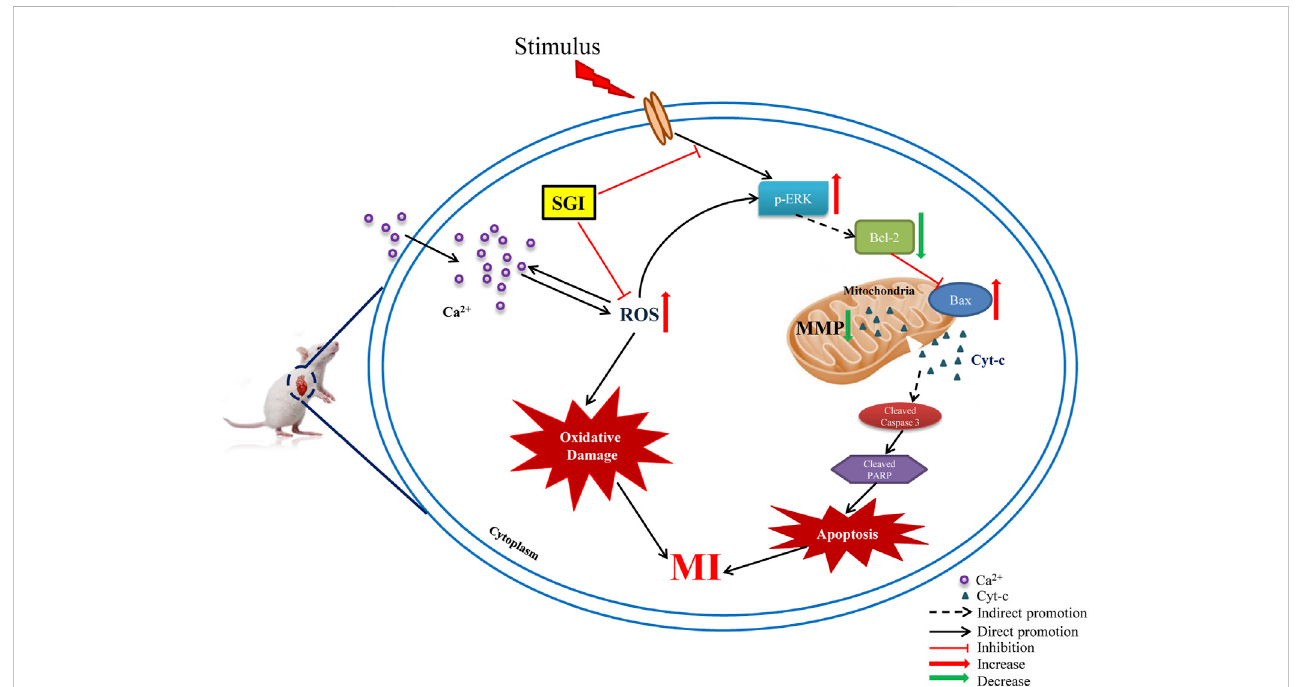
FIGURE 10 Schematic diagram of the underlying molecular mechanism of SGI against MI. ROS (reactive oxygen species); MI (myocardial ischemia); MMP (mitochondrial membrane potential); p-ERK1/2 (phosphorylation extracellular signal-related kinases1/2); Cyt-c (cytochrome c); PARP (poly-ADP ribose polymerase); Caspase-3 (cysteinyl aspartate speci fi c proteinase